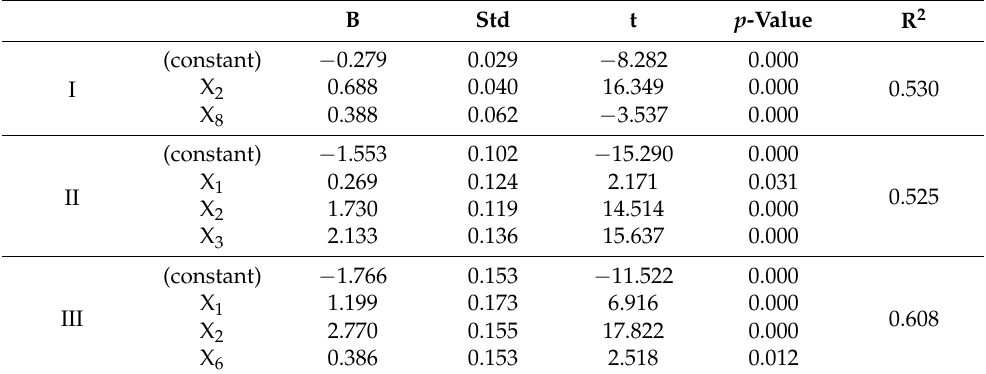
Table 4. Proposed MLR